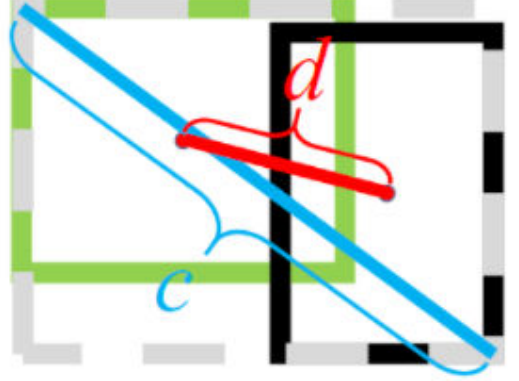
Figure 6. The schematic diagram of calculation process R. d is the Euclidean distance and c represents the diagonal length of the smallest box containing two boxes.